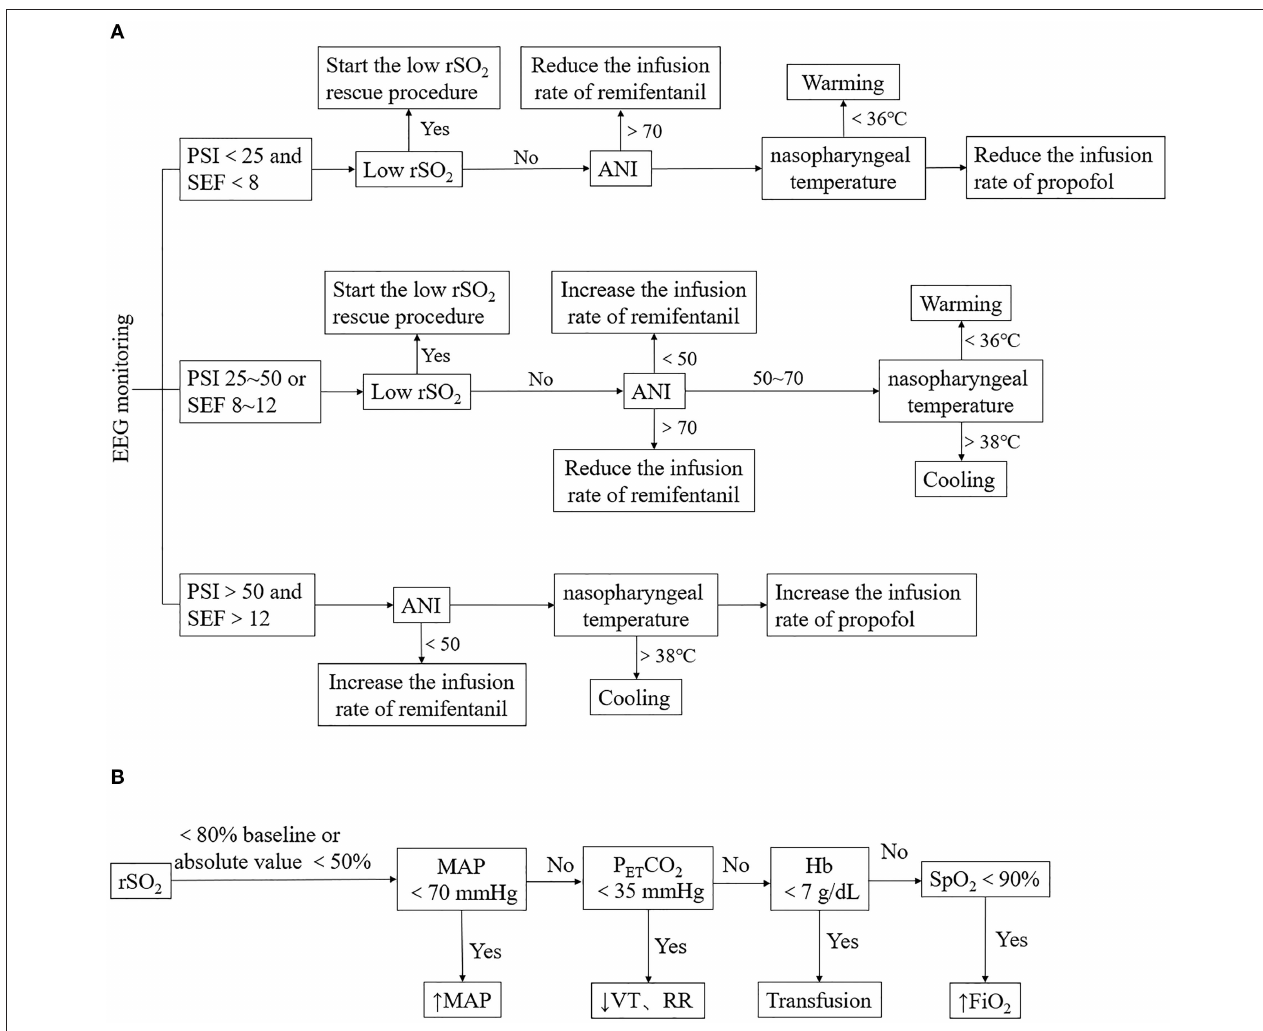
FIGURE 1 | Anesthesia management of Group I. (A) Management based on multimodal brain monitoring. The management is triggered by PSI with the SEF, rSO 2 , ANI, and nasopharyngeal temperature were observed in sequence. Low rSO 2 rescue procedure, adjustment of the infusion rate of remifentanil or propofol, warming or cooling was conducted according to the change of parameters. (B) Low rSO 2 rescue procedure. MAP, P ET CO 2 , Hb, and SpO 2 were adjusted when low rSO 2 occurred. PSI, patient status index; SEF, spectral edge frequency; ANI, analgesia nociception index; rSO 2 , regional cerebral oxygen saturation; MAP, mean arterial pressure; P ET CO 2 , end-tidal carbon dioxide partial pressure; VT, tidal volume; RR, respiration frequency; Hb, hemoglobin; SpO 2 , pulse oxygen saturation; FiO 2 , fraction of inspiration